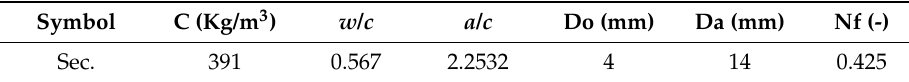
Table 9. LDPM mix-design parameters.